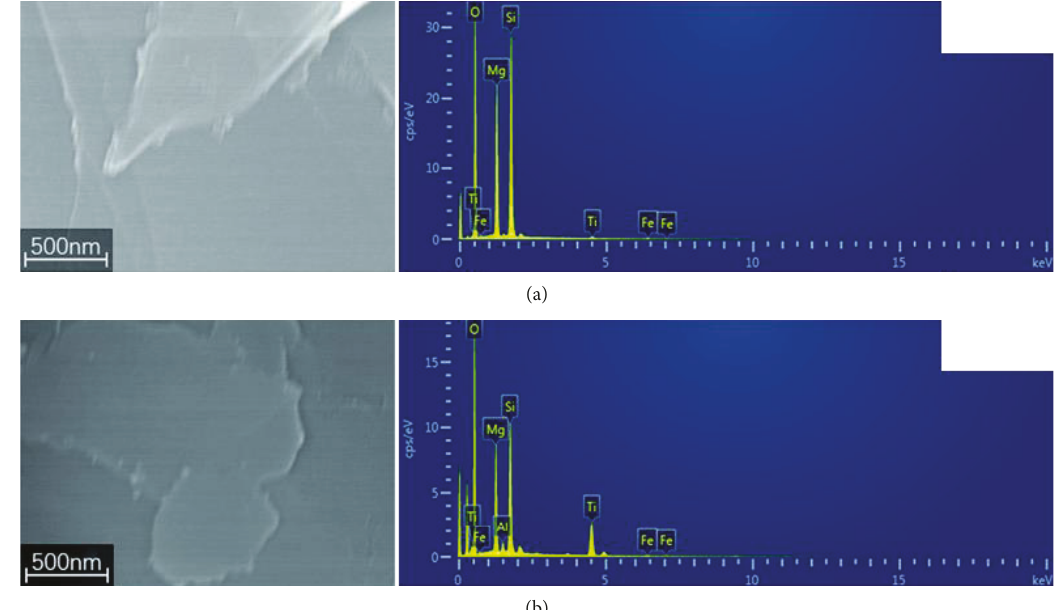
Figure 5: EDS spectrum of the nanocomposites ((a) T-H; (b)